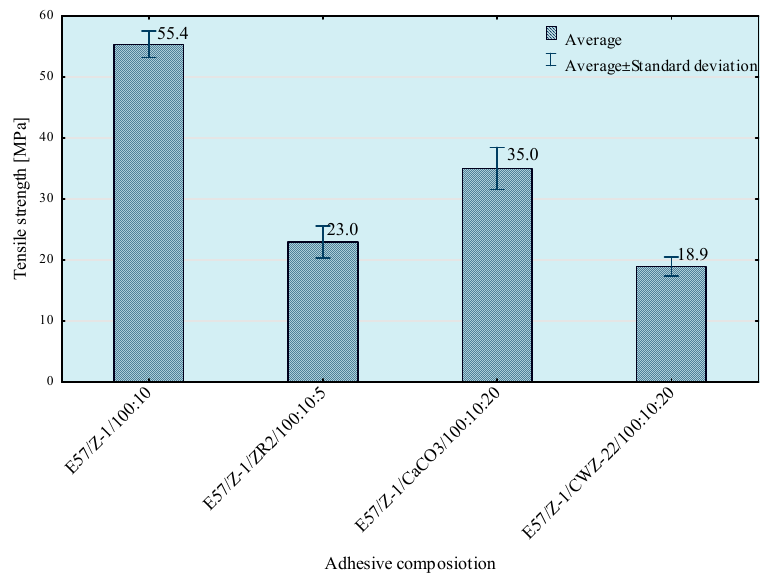
Figure 20. Results of tests of average tensile strength of compositions prepared with 5 mixing methods at 2500 rpm.